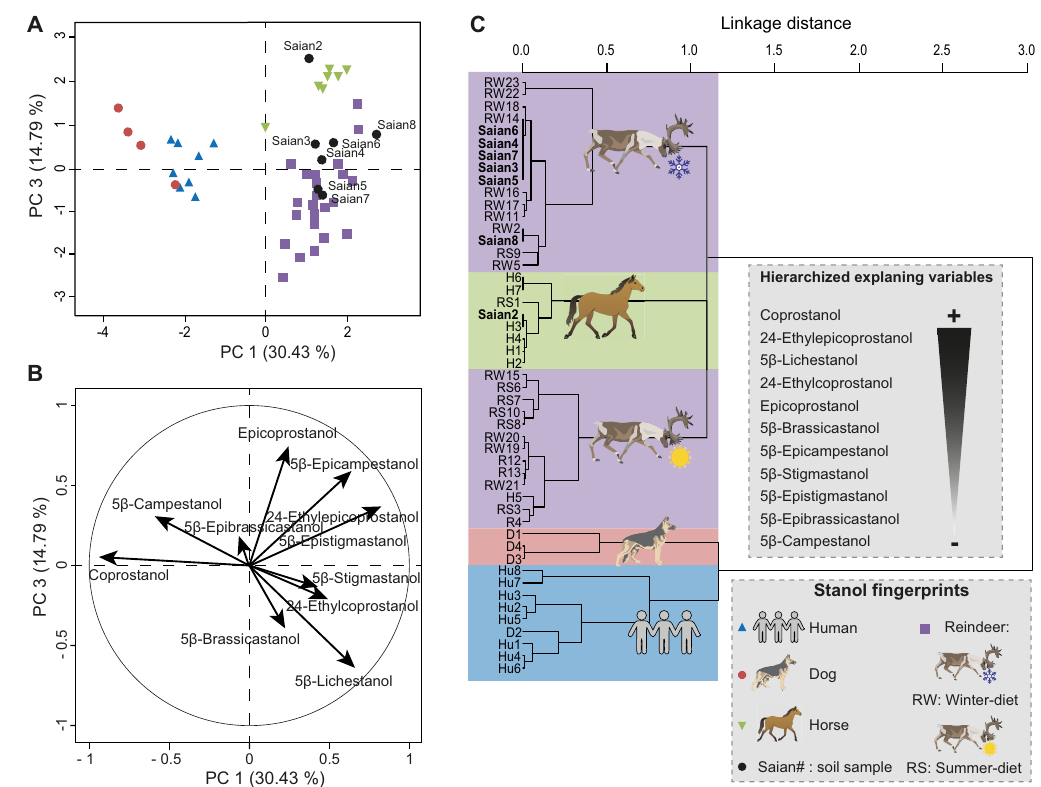
Fig 3. Identification of soil faecal fingerprints from the contemporary Tofa (Sai ͡ an Mountains) camp by multivariate analyses on eleven 5 β - stanol distributions. ( A ) PCA score plot of 5 β -stanol distributions from the reference library of faeces of dogs, horses, humans and reindeer, together with soil samples from the site. PC 1 and PC 3 represent principal components 1 and 3 respectively. The numbers in brackets show the variance explained by each PC. ( B ) PCA correlation circle. ( C ) HCPC dendrogram of dog (D), horse (H), human (Hu), reindeer (R) and soil sample (Saian) fingerprints. The main variables/compounds responsible for the distinction between the main clusters are hierarchized (from the more important + to the less import -) according to S5 Table. More details of the PCA/HCPC models can be found in S5 Table and sample information is in S2 Table. R4 = (24-Ethylepicoprostanol / 24-Ethylcoprostanol) + (Epicoprostanol / Coprostanol); with no horse = 0.8 < R4 < 1.2 = horse [10]